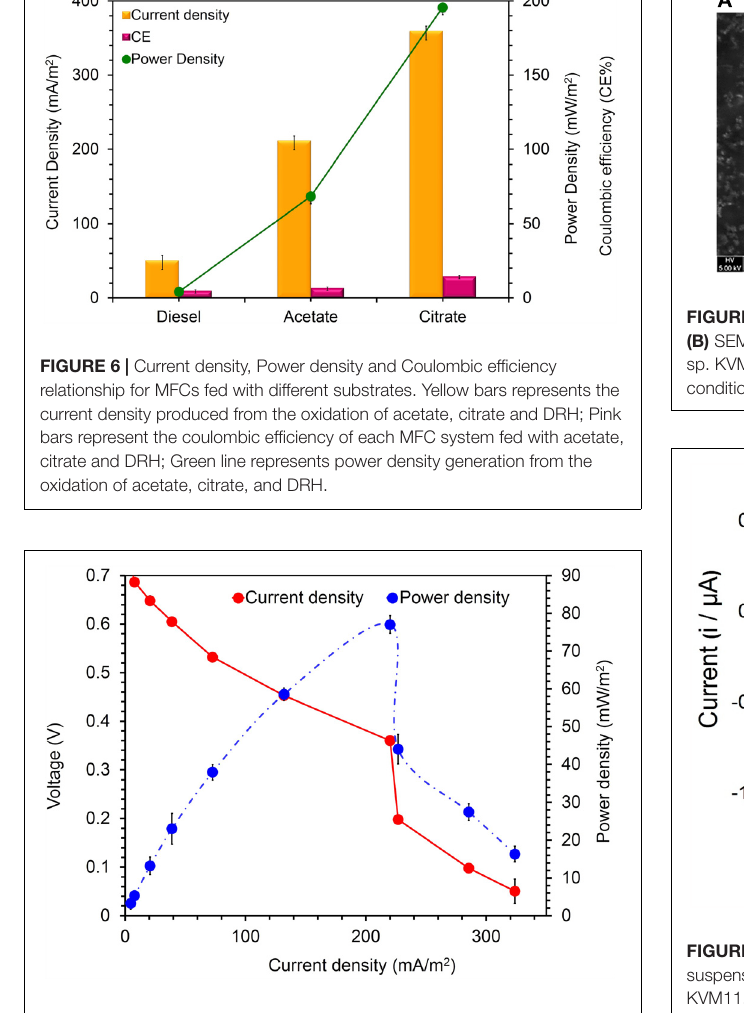
FIGURE 7 | Current- voltage and current-power relationship for MFCs fed with acetate (1g/L) Citrobacter sp. KVM11. Red circles represent the current density produced from the oxidation of acetate in MFCs; Blue circles represent the power density generated from the oxidation of acetate in MFCS.